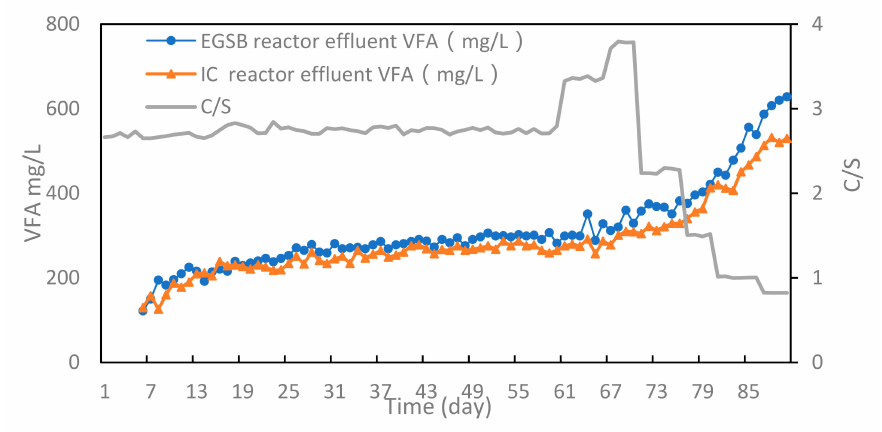
Figure 8. VFA change of reactor